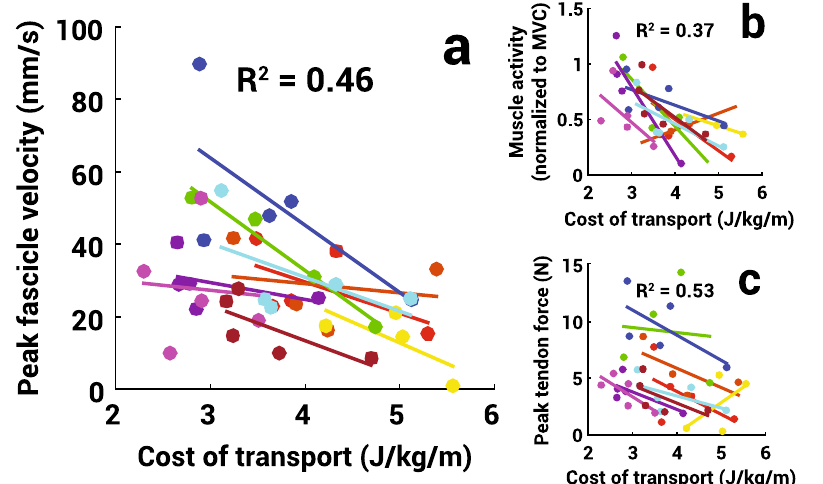
Figure 3. ( a ) Peak TA fascicle lengthening velocity, ( b ) peak TA muscle activity, and ( c ) peak TA tendon force as a function of whole-body metabolic COT with the adjusted R 2 for the linear mixed model across all subjects. Each color represents an individual subject with dots as the mean value for a given walking condition and lines as the linear fit for a single subject across conditions.